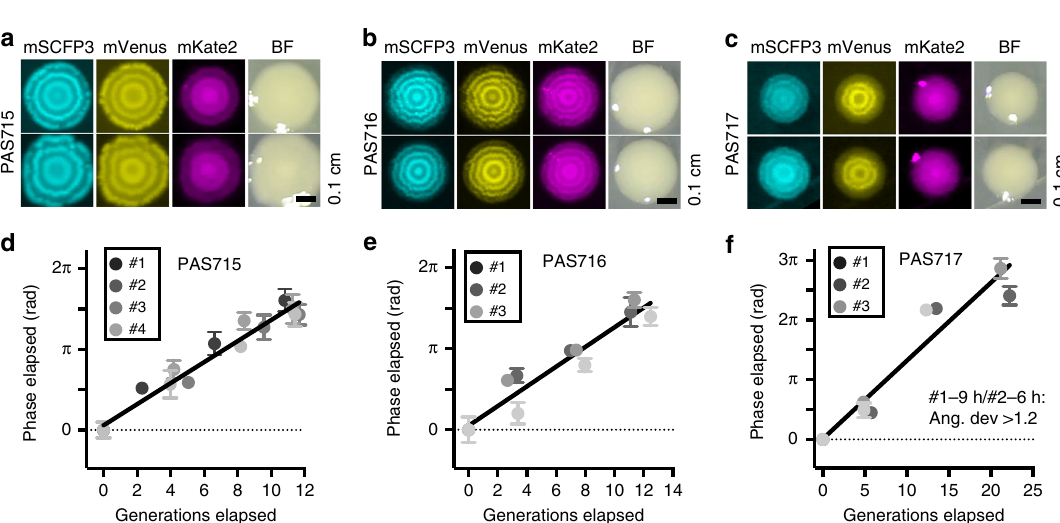
Fig. 2 RINGS can assess growth in different bacterial strains and species. a – c Fluorescence and white light images of two representative colonies of PAS715 ( E. coli MG1655), PAS716 ( S . Typhimurium LT2), and PAS717 ( E. coli Nissle 1917). Scale bars = 0.1 cm. d – f When grown in log-phase liquid culture, repressilator phase progression correlated with the estimated generations elapsed as determined by CFU counts for PAS715 (four biological replicates), PAS716 (three biological replicates), and PAS717 (three biological replicates). Graphs also show linear regression from combined means of elapsed phase